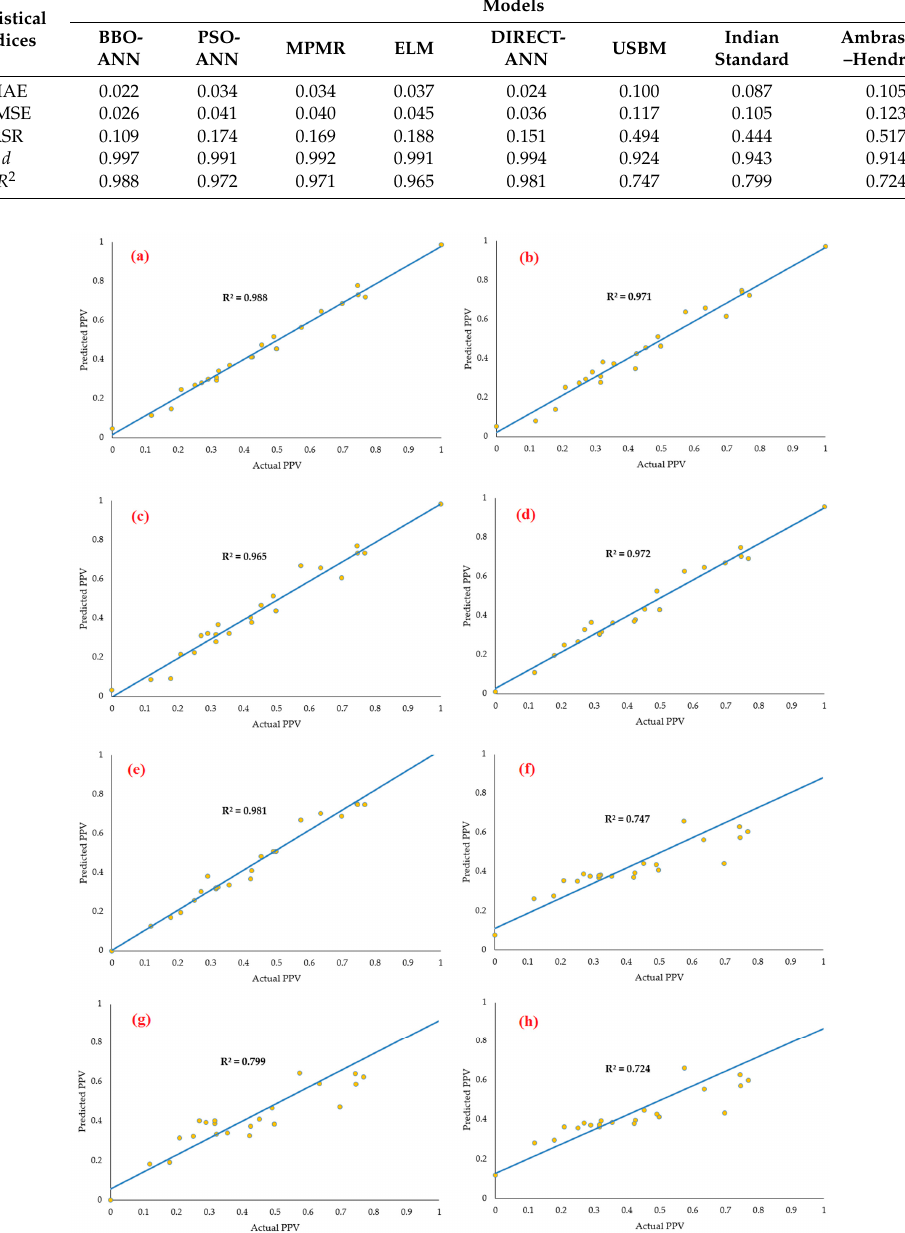
Figure 6. Scatter plot displaying the actual PPV values versus the predicted PPV values on the testing dataset using the ( a ) BBO-ANN, ( b ) MPMR, ( c ) ELM, ( d ) PSO-ANN, ( e ) DIRECT-ANN, ( f ) USBM, ( g ) Indian Standard, and ( h ) Ambraseys–Hendron methods.